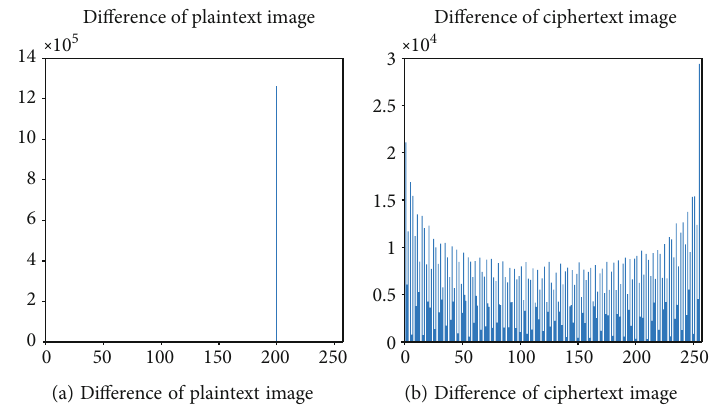
Figure 6: Histogram of each color component of Lena plaintext image and ciphertext image. Table 2: Average values of NPCR and UACI in 100